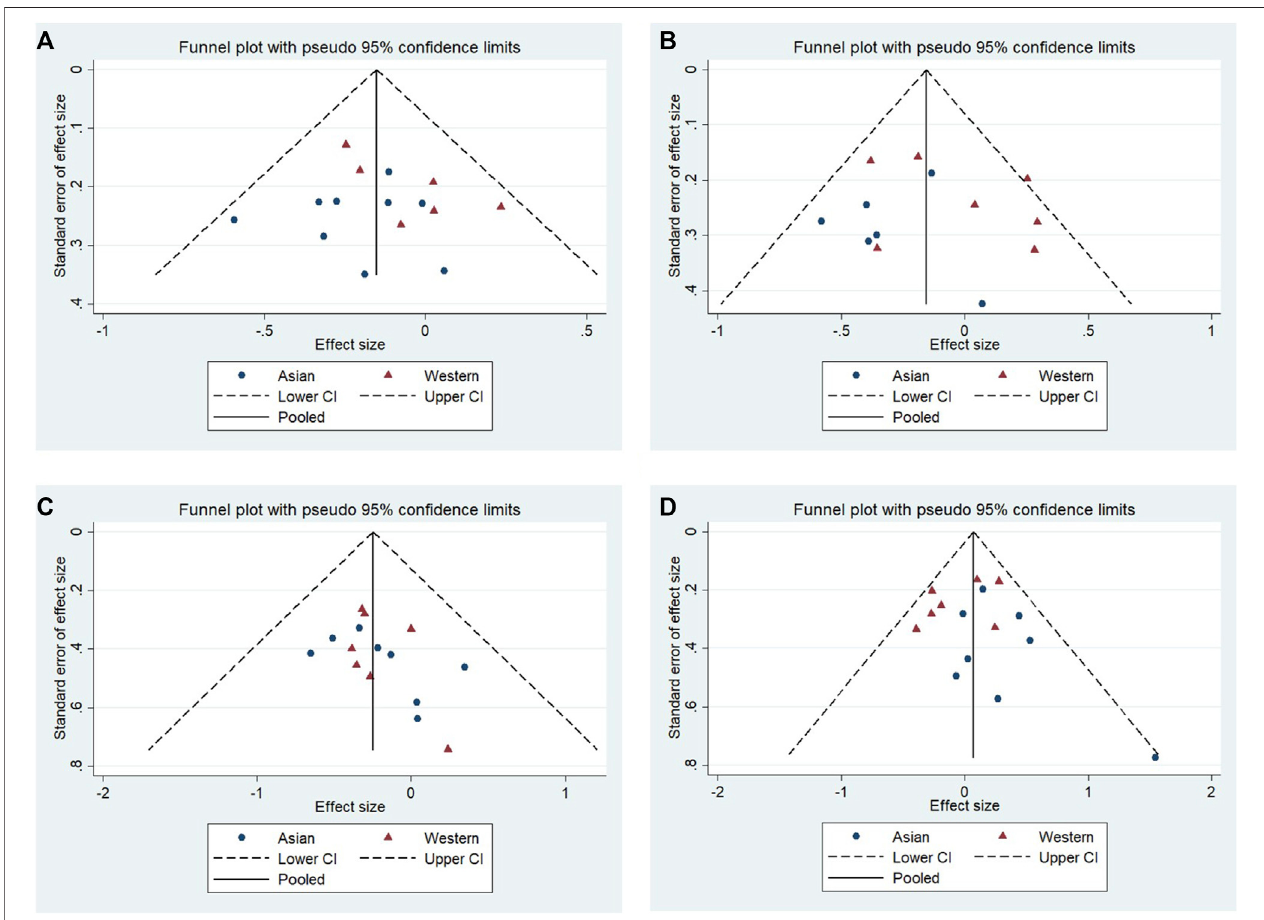
FIGURE 5 | Funnel plot of the odds ratios in the subgroup: Asian populations and Western populations. (A) Allele model, 10R vs. all others. (B) Pseudodominant model, 10R/10R + 10R/9R vs. all others. (C) Pseudorecessive model, 10R/10R vs. all others. (D) Pseudocodominant model, 10R/9R vs. all others.